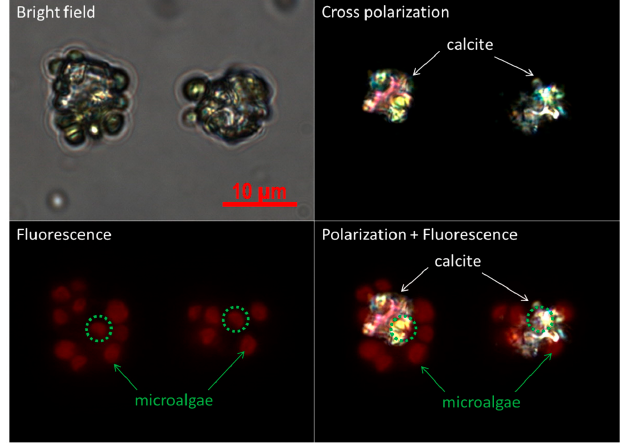
Figure 3. Optical microscopic images of the initial stage of CaCO 3 crystals in the presence of microalgal cells in the mode of bright-field, cross-polarization, fluorescence, and the overlay of polarization and fluorescence.